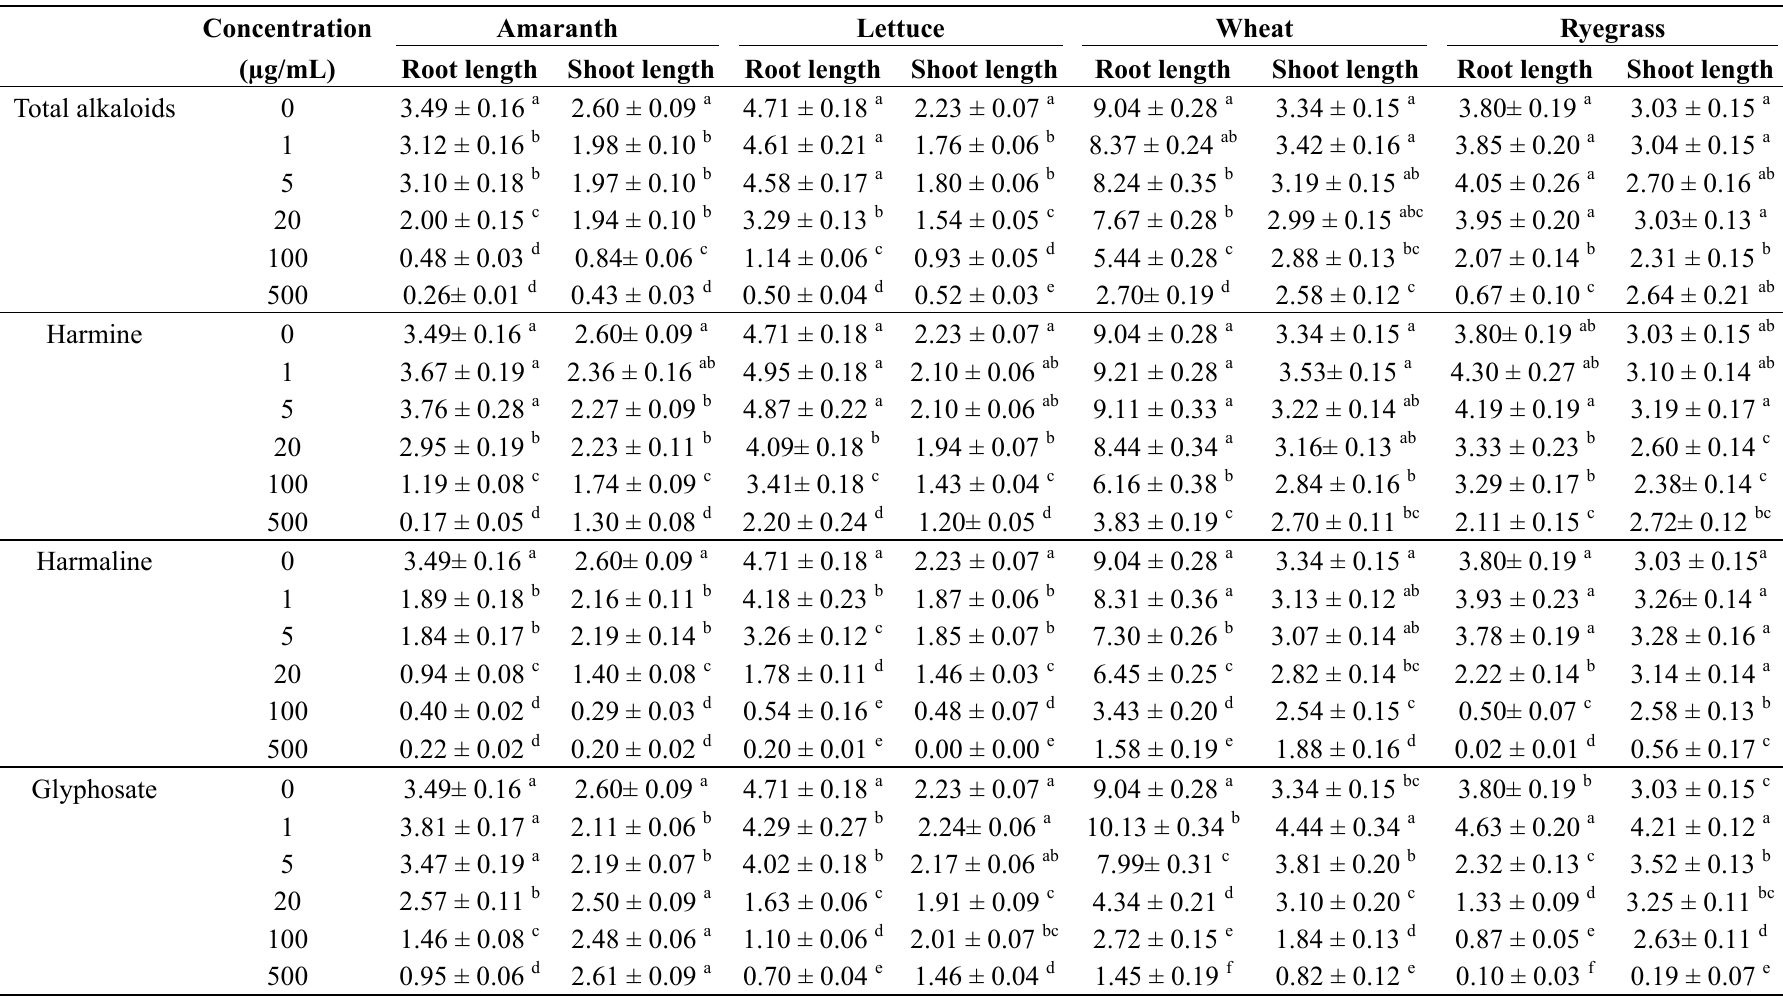
Table 2. Phytotoxic effects of total alkaloids, harmine, harmaline and glyphosate on receiver plants at 1~500 μ g/mL.